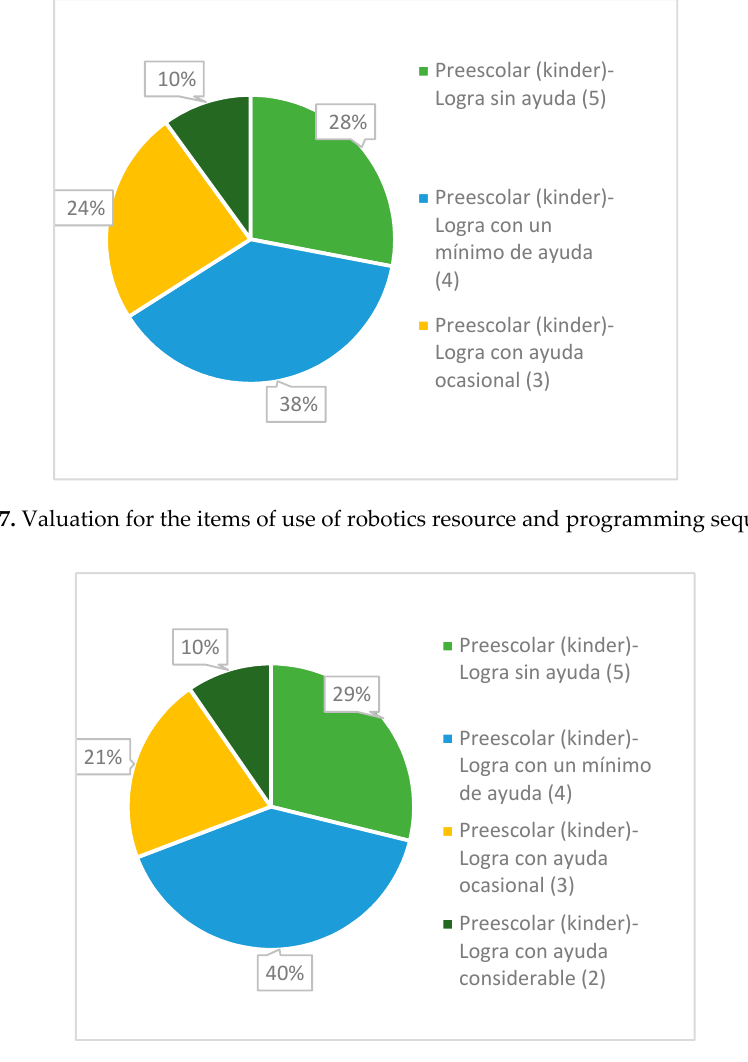
Figure 8. Valuation for the items in